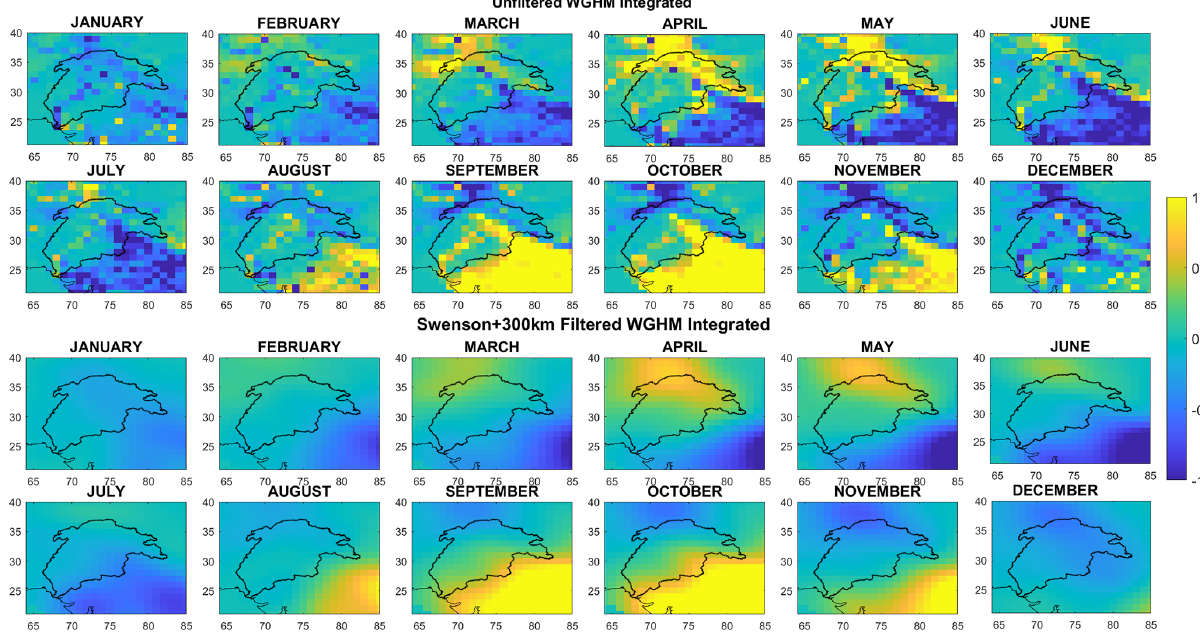
Figure 8. Mean mass anomalies (in Gt) for each month from April 2002–December 2016 obtained from WGHM Integrated: unfiltered (top) and filtered (bottom). Refer to Fig. 2 for land cover information.